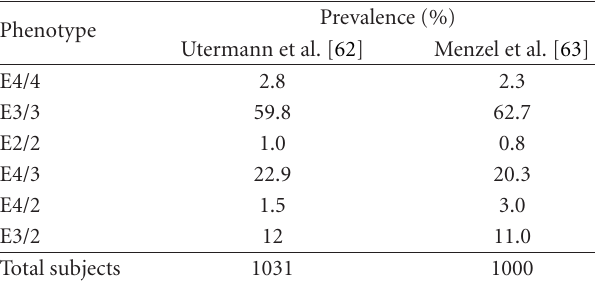
Table 2: ApoE genotype